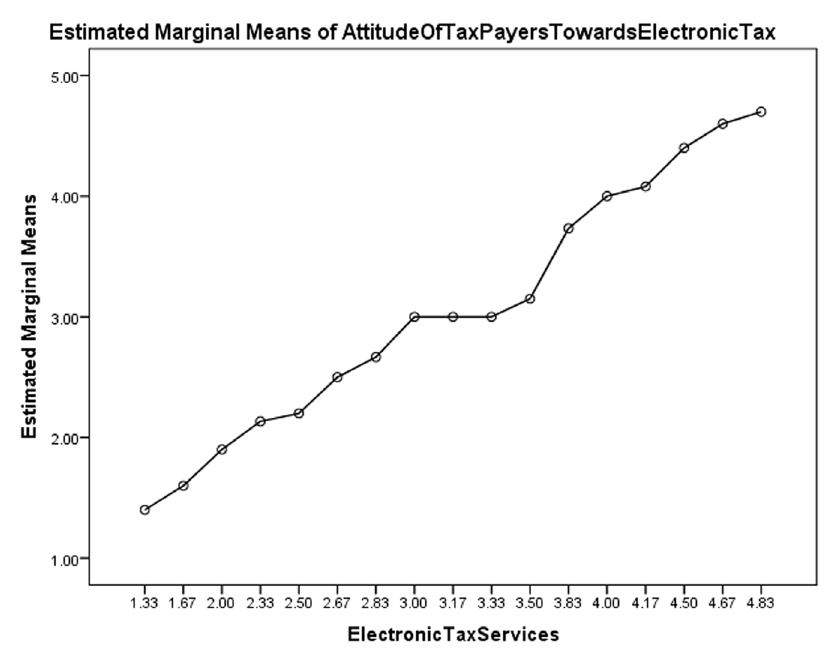
Figure 2. Frequency of E-tax services and Attitude of